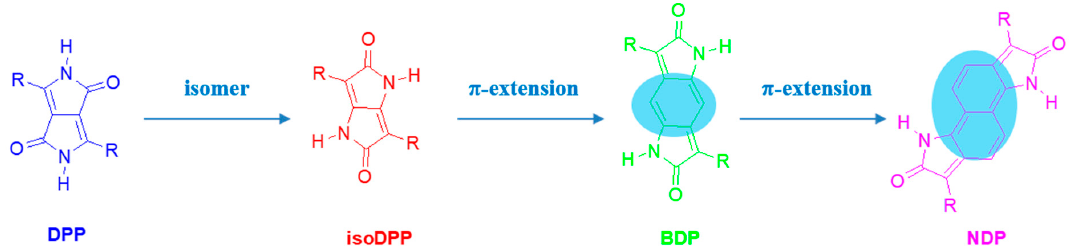
Figure 2. Chemical structure of diketopyrrolopyrrole (DPP), 1,3,4,6-tetraarylpyrrolo[3,2-b]pyrrole- 2,5-dione (isoDPP), benzodipyrrolidone (BDP), and naphthodipyrrolidone (NDP).